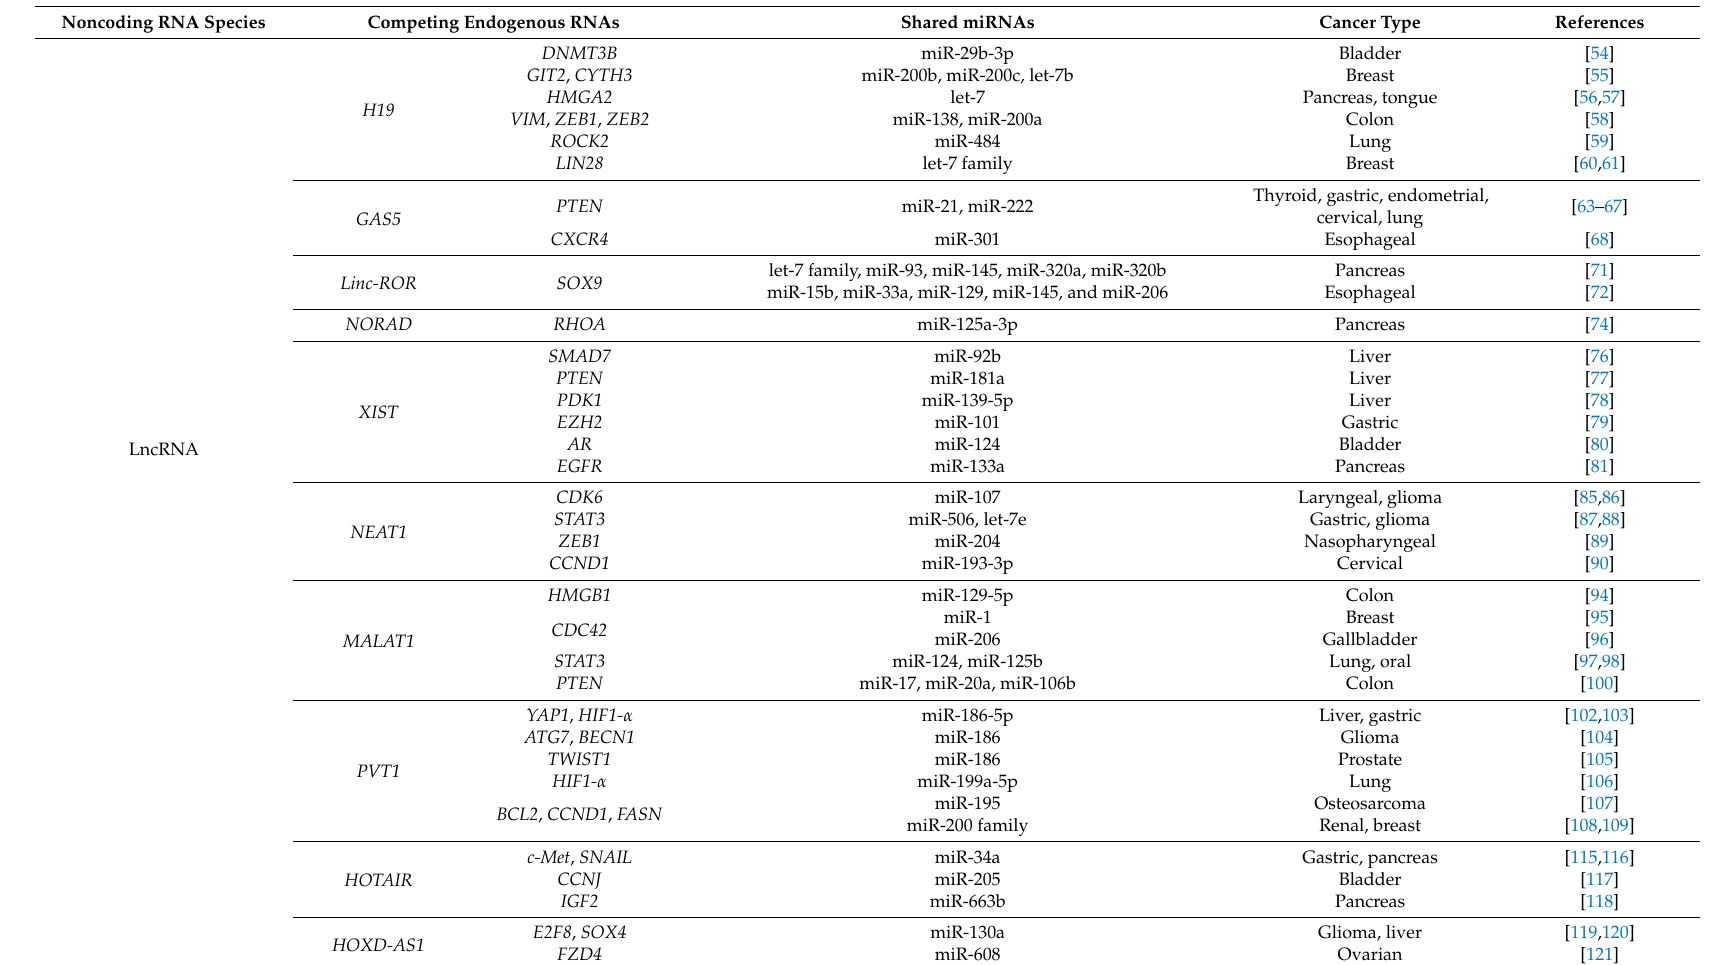
Table 1. miRNA/ceRNA interactions in different